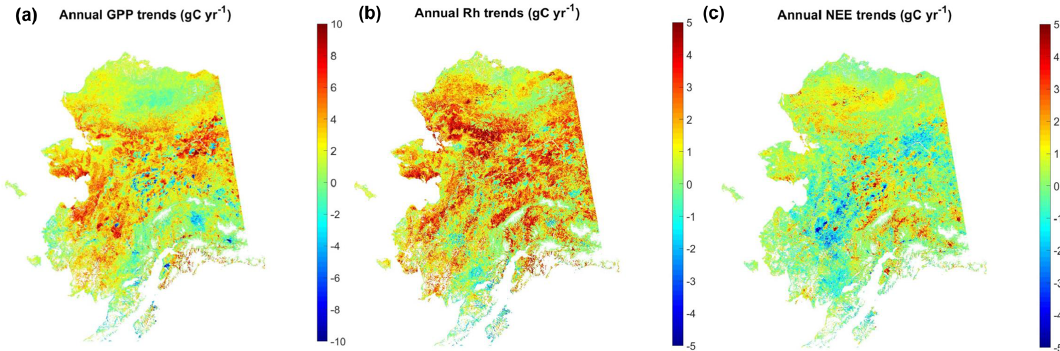
Figure 8. Temporal trends of model-estimated annual carbon fluxes from 2001 to 2017. For NEE, positive trends indicate decreasing net carbon uptake activity, while negative trends indicate enhanced net ecosystem carbon uptake.